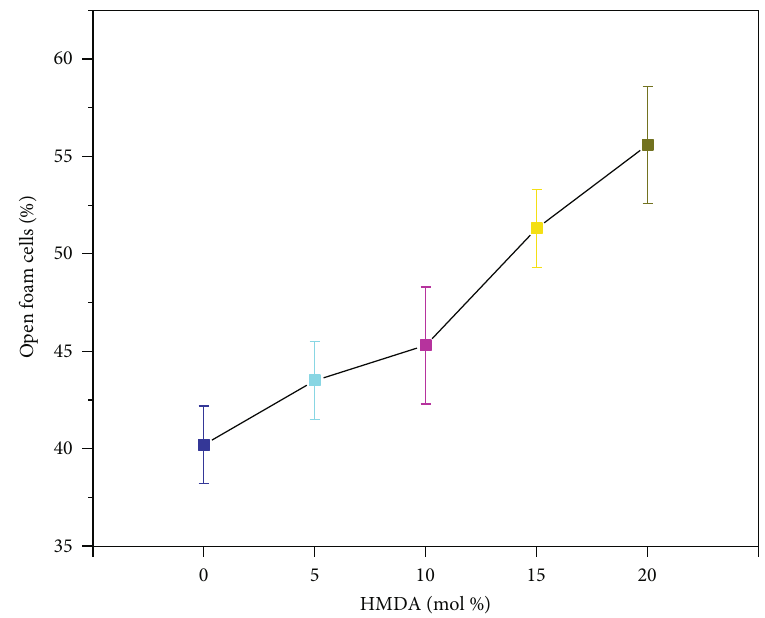
Figure 11: % open cells of PIFs with various HMDA